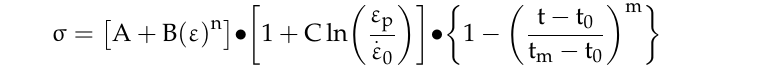
Table 4. Johnson-Cook constitutive model parameters of 7075AL aluminum alloy [28].